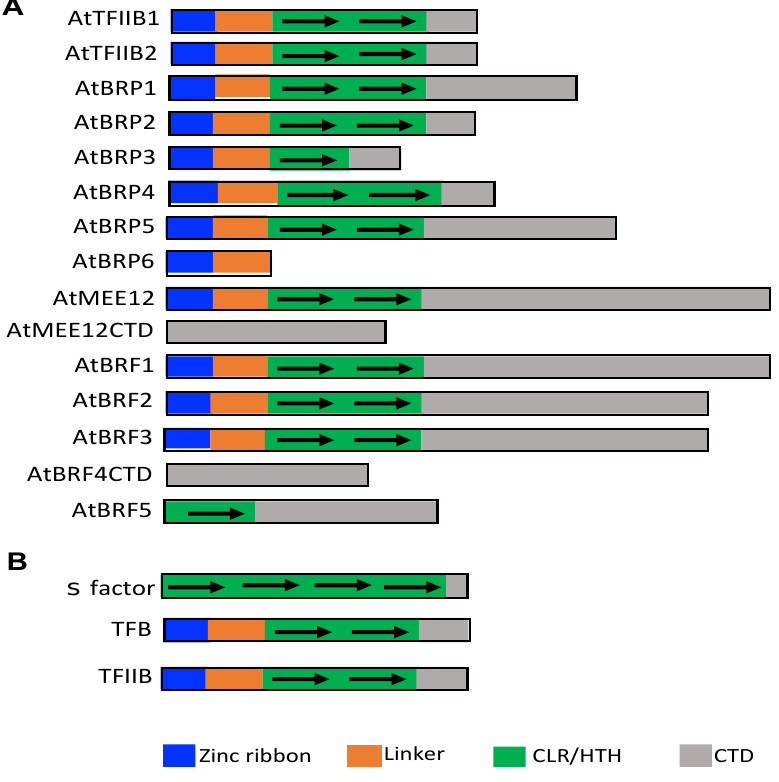
Figure 1. Functional domains of Arabidopsis TFIIB-like proteins in Arabidopsis ( A ) and comparison of bacterial s factor, archaeal TFB and eukaryotic TFIIB protein structures ( B ).